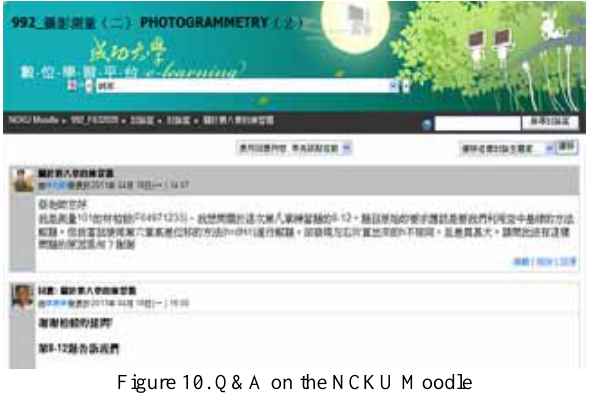
Figure 10. Q&A on the NCKU Moodle